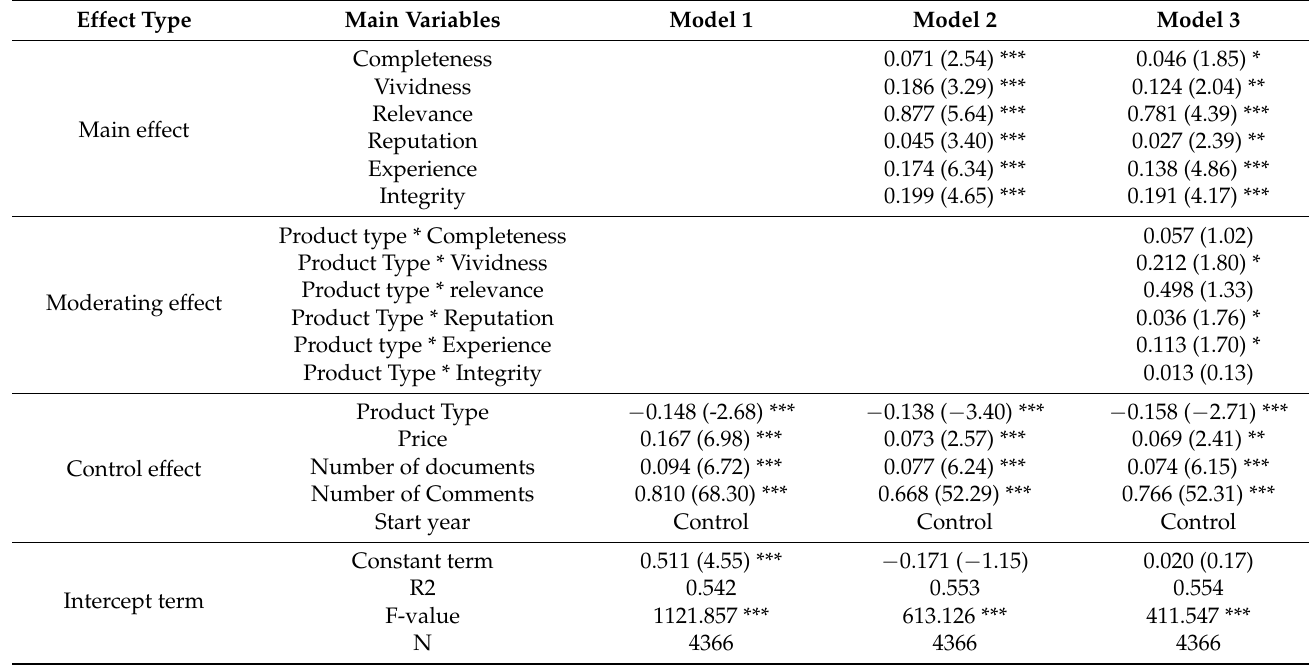
Table 6. OSL regression analysis